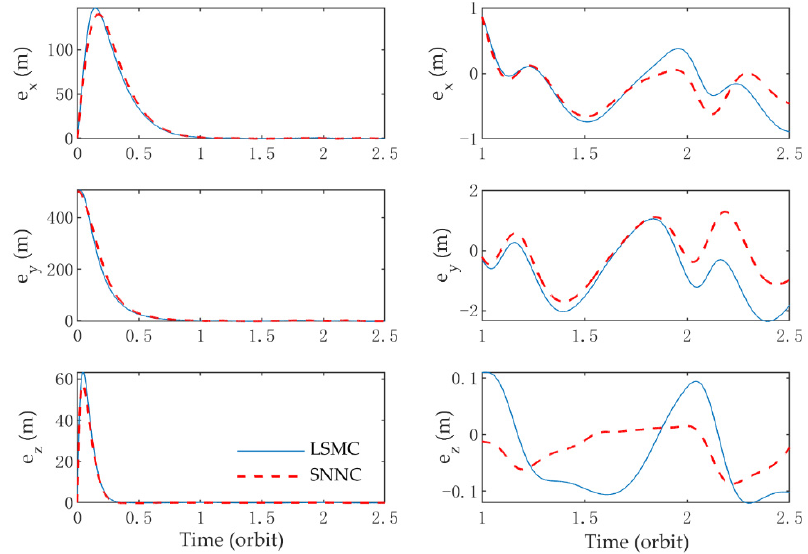
Figure 2. Time histories of relative position errors for the case without radial control.